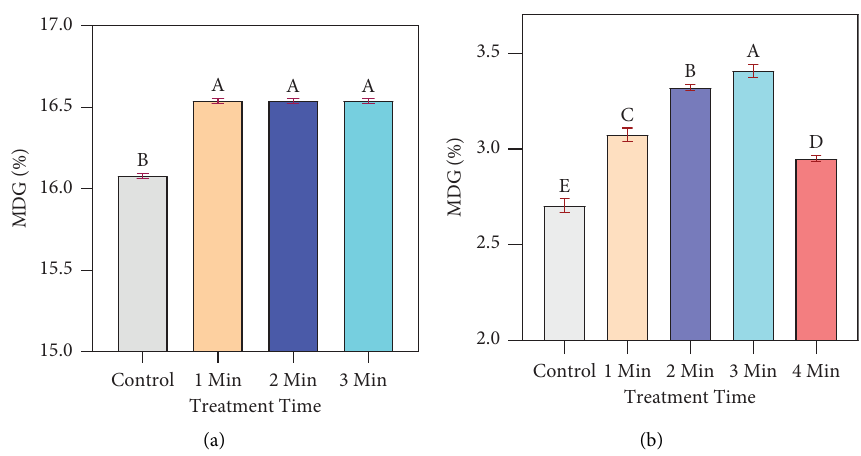
Figure 14: Mean daily germination of (a) radish and (b) carrot seeds.